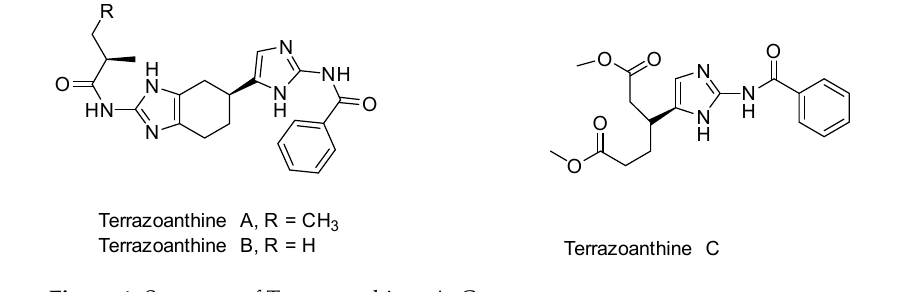
Figure 1. Structure of Terrazoanthines A–C.